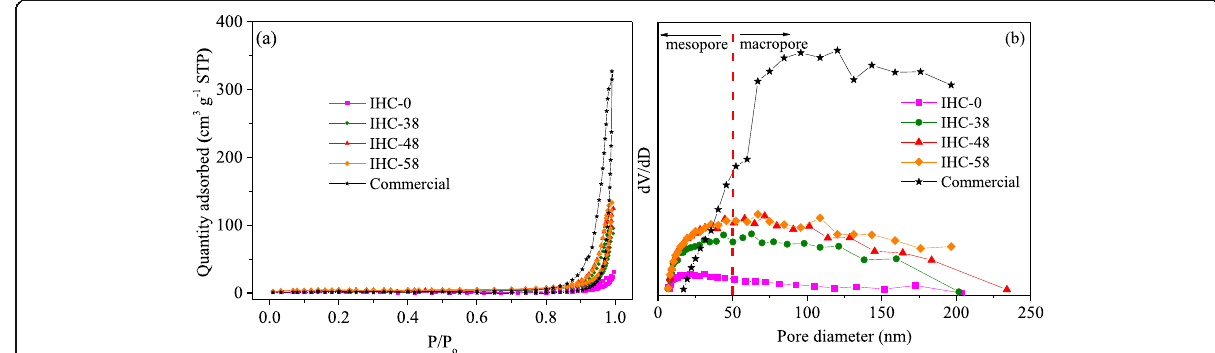
Fig. 6 A N 2 adsorption-desorption isotherms and ( B ) pore size distributions of IHC-s and commercial